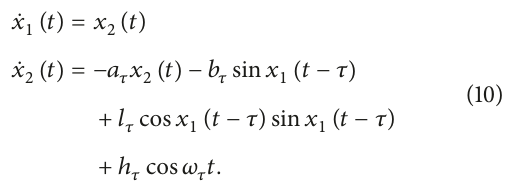
shows multiple chaotic regions for 0.0001 ≤ 𝜏 ≤ 0.01 , 0.15 ≤ 𝜏 ≤ 0.35 , 0.4 ≤ 𝜏 ≤ 0.72 , and 0.77 ≤ 𝜏 ≤ 0.9 . The